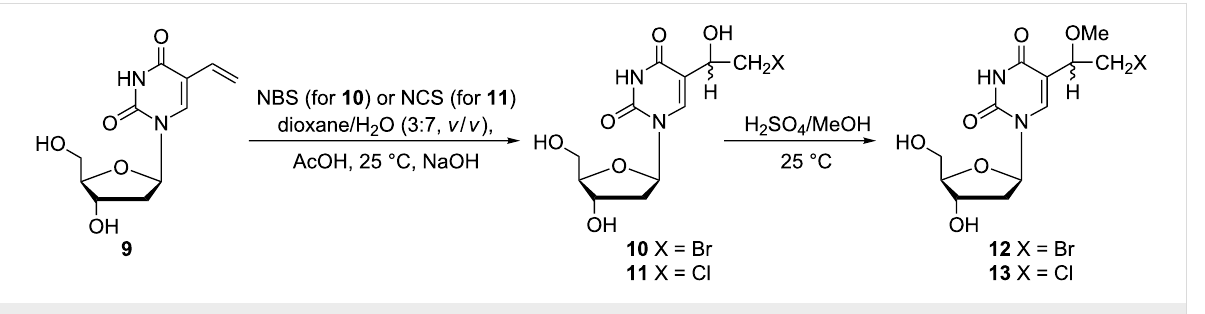
Scheme 3: Synthesis of 5-(methoxy-2-haloethyl)-2'-deoxyuridines 12 and 13 .